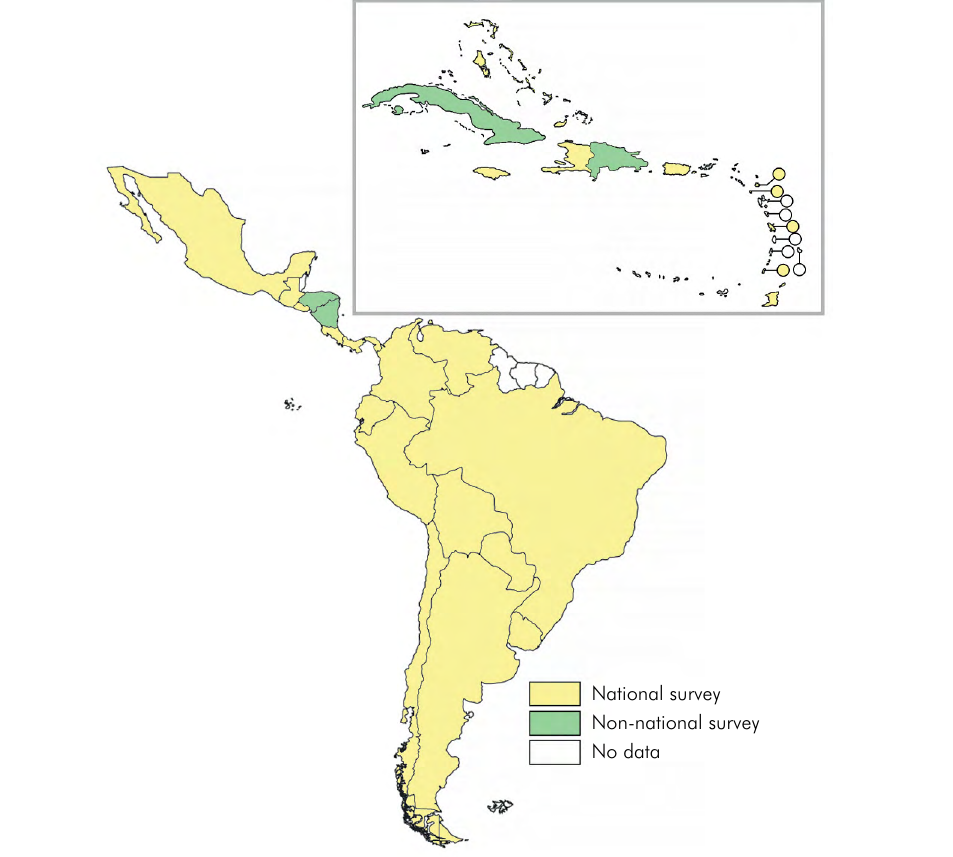
Figure 1. Representativeness of epidemiological studies in Latin American and Caribbean countries.